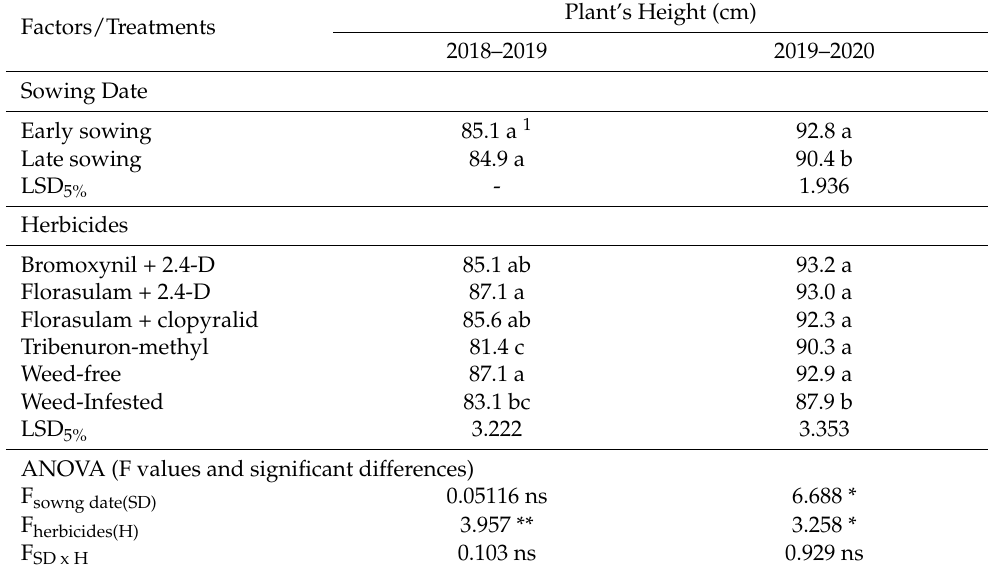
Table 5. Durum wheat plant’s height (cm) as affected by the sowing date (early and late sowing) and the herbicide treatments (bromoxynil + 2.4-D, florasulam + 2.4-D, florasulam + clopyralid, tribe- nuron-methyl, weed-free, and weed-infested).